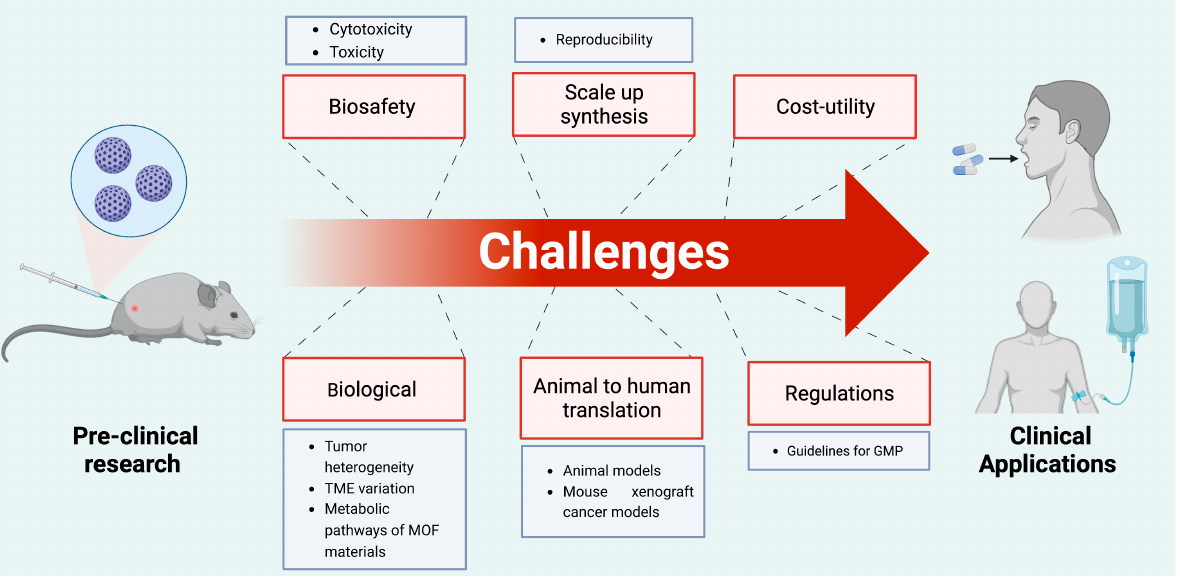
Figure 10. A summary illustration of the major clinical translation challenges of MOF-based treatments. Clinical application hurdles include biology, biosafety, animal-to-human translations, scaling up manufacturing, regulatory, and cost-utility issues. Created with BioRender.com .